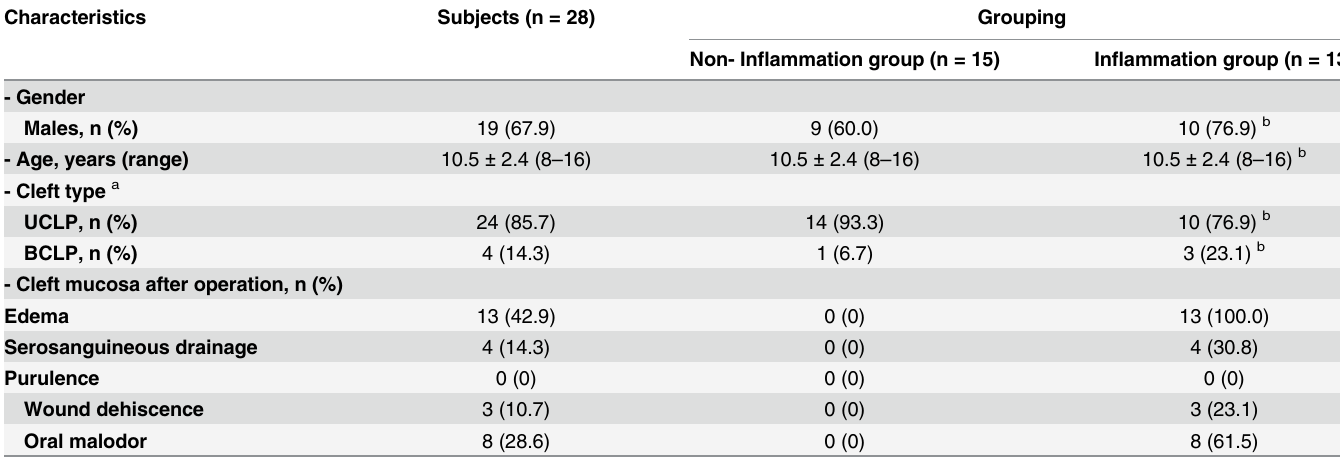
Table 1. Dehmographic and clinical characteristics of studied subjects.